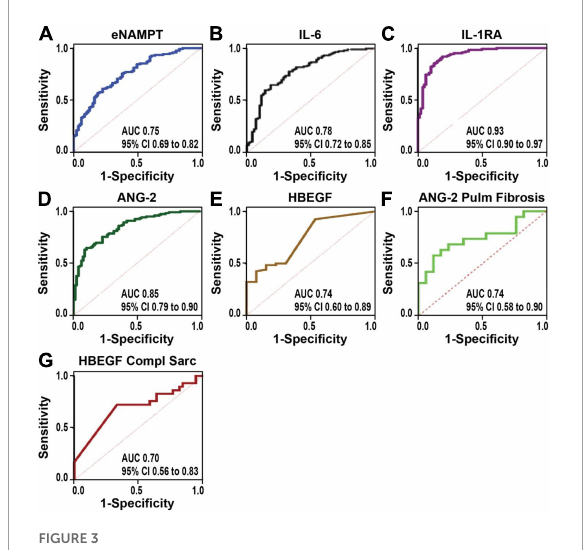
FIGURE3 The receiver-operator characteristics curves (ROC) assessing the diagnostic accuracy power. (A–E) Sarcoidosis vs. controls. eNAMPT (A) , IL-6 (B) , IL-1RA (C) , ANG-2 (D) , and HBEGF (E) . IL-1RA showed the highest discriminatory accuracy between sarcoidosis and healthy controls (AUC of 0.93, 95% CI of 0.90–0.95), followed by ANG-2 (AUC 0.85, 95% CI of 0.79–0.90). (F,G) Progressive sarcoidosis. ANG-2 diagnostic accuracy performed well to distinguish sarcoidosis pulmonary fibrosis vs. sarcoidosis without pulmonary involvement (Stages I and II) (F) and HBEGF showed a good discriminatory power to differentiate complicated